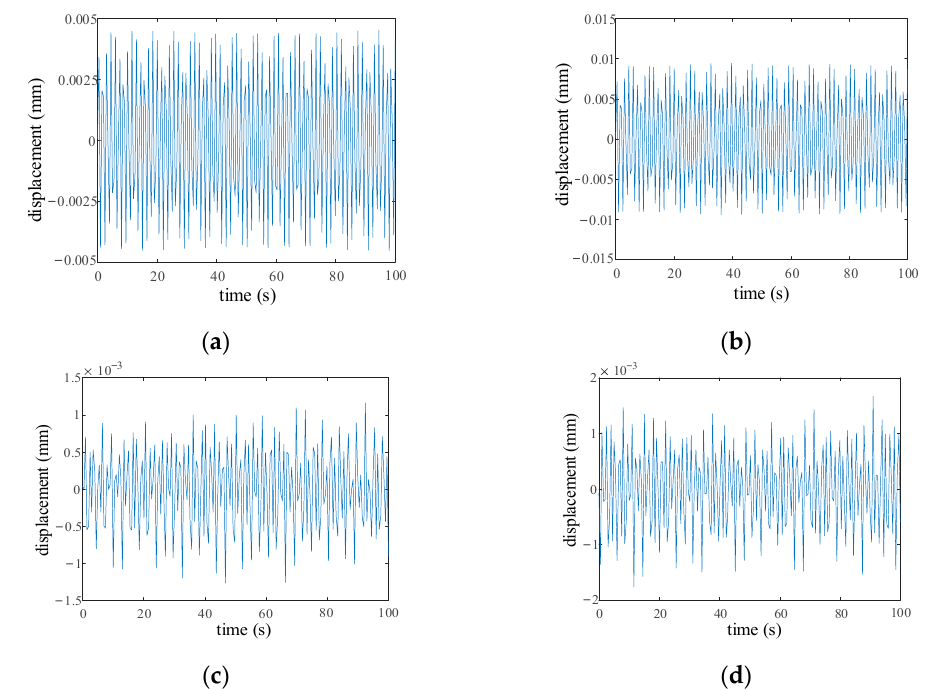
Figure 7. The time domain response of some components in the second stage. ( a ) Rotational displacement u p12 ; ( b ) rotational displacement u p22 ; ( c ) radial displacement η p22 ; ( d ) horizontal displacement X c2 of the carrier.